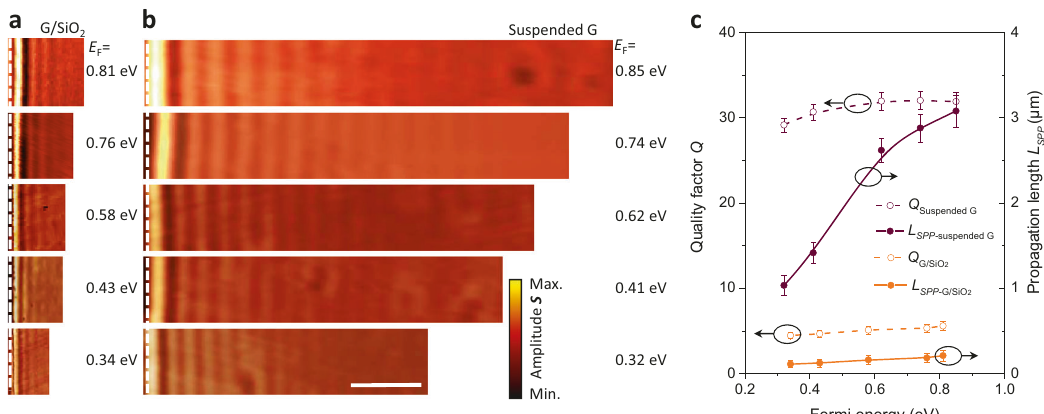
Fig. 2 High-quality factor and long-distance propagation of suspended GPs. a , b Measured near- fi eld amplitude images of SiO 2 -supported graphene ( a ) and suspended graphene (suspension height ~450 nm) ( b ) near the edge (white dashed line) for different graphene Fermi energies and fi xed illumination wavelength λ 0 = 10.87 μ m (920 cm − 1 ). The scale bar indicates 3 μ m. c Quality factor Q (left axis) and propagation length L SPP (right axis) of suspended (maroon curves) and SiO 2 -supported (orange curves) GPs as a function of Fermi energy. Symbols are obtained from experimental data, while curves are a guide to the eye. Error bars indicate 95% con fi dence subindices 1 and 2 indicate the real and imaginary parts,